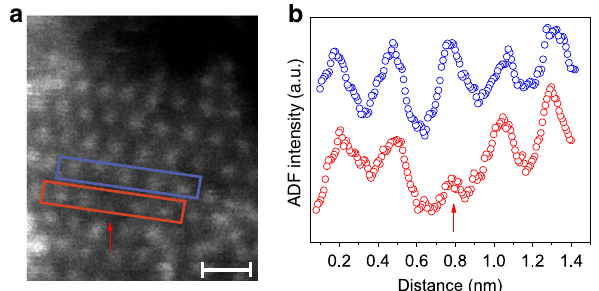
Fig. 2 STEM characterization of Ni@1T-MoS 2 sample. a Atomic resolution ADF-STEM image of monolayer sample at 60 keV. The length of the scale bar is 5 Å. b Intensity pro fi les taken along two adjacent lines indicated by blue and red rectangles in ( a ). The red arrow points to the location of Ni